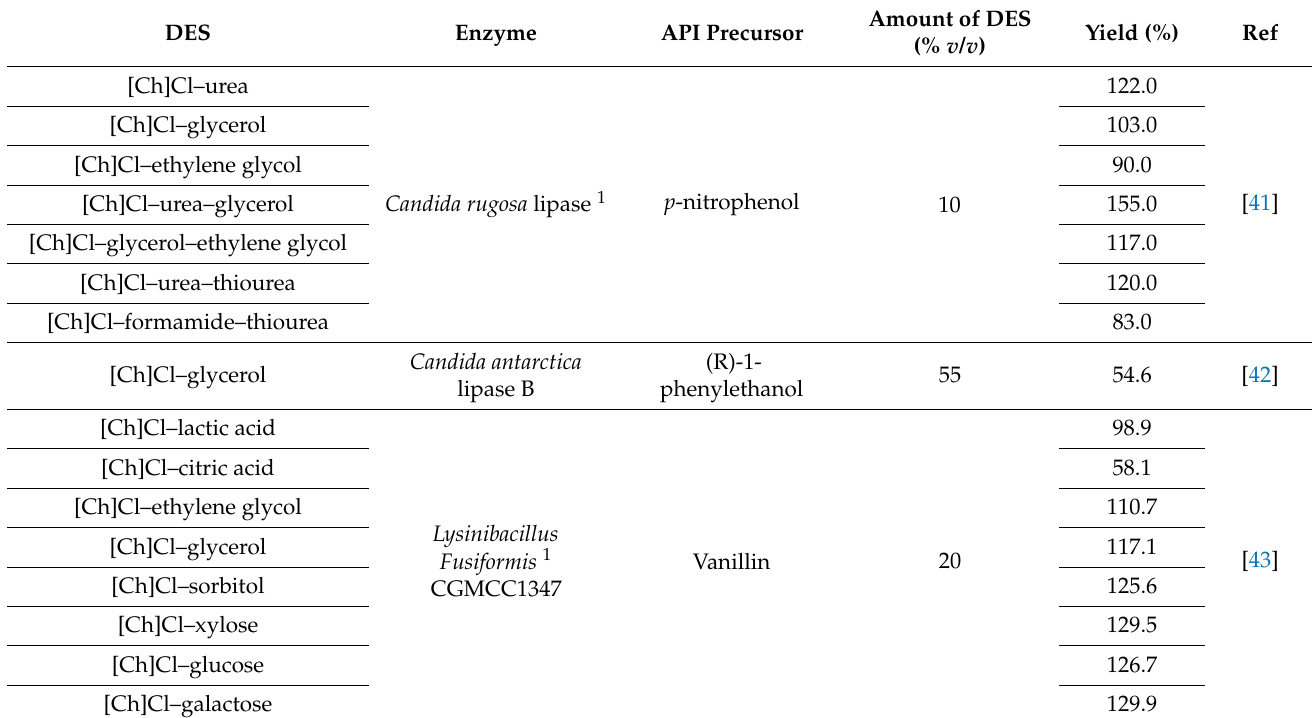
Table 2. Summary of the main results and conditions of cholinium ([Ch])-based DES used in biocatalysis for the production of APIs